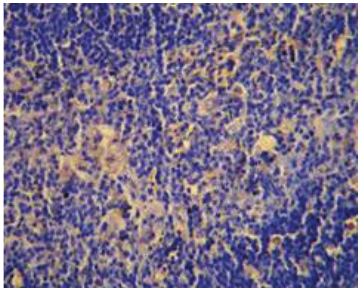
Figure 13: Model control group—7d in OJ experiment thymus (+++), Bax × 200.